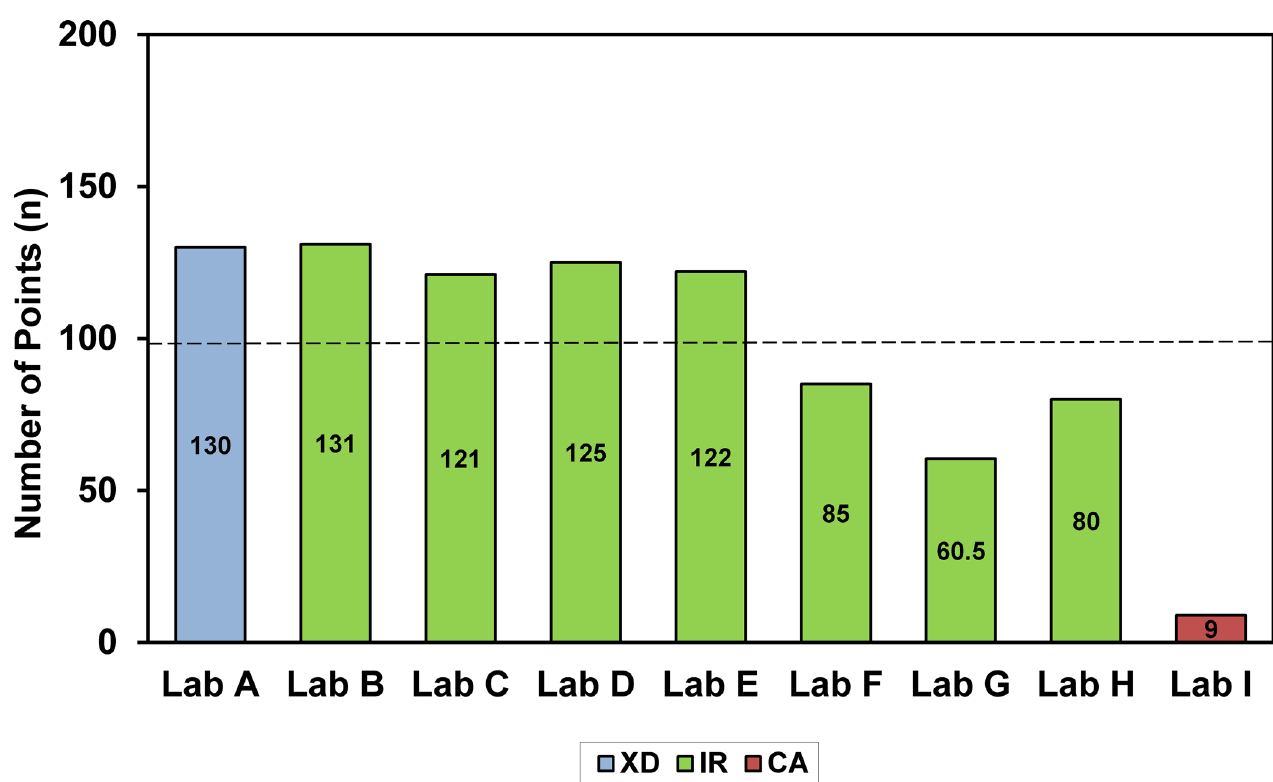
Fig 1. Evaluation of analytical results of laboratories (maximum: 132 points; minimum: 99